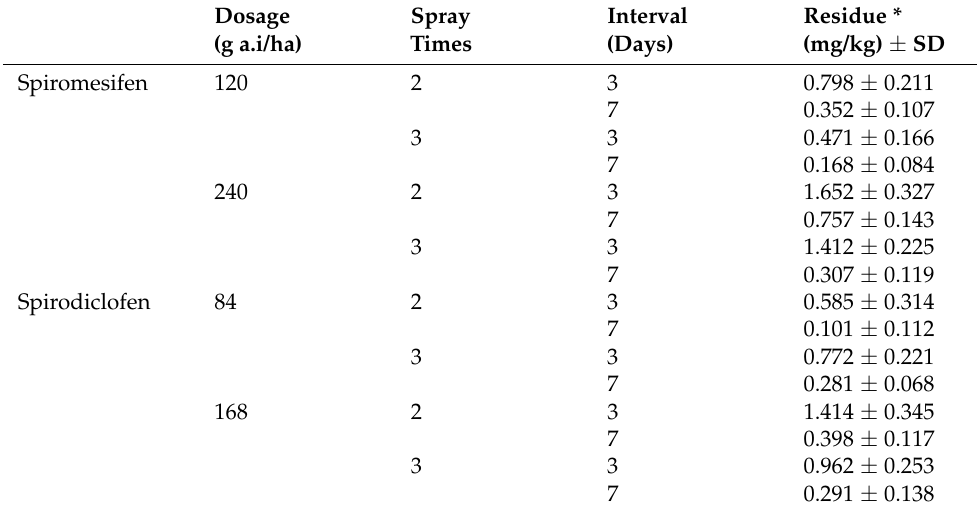
Table 5. Terminal residue of spiromesifen and spirodiclofen in tomato